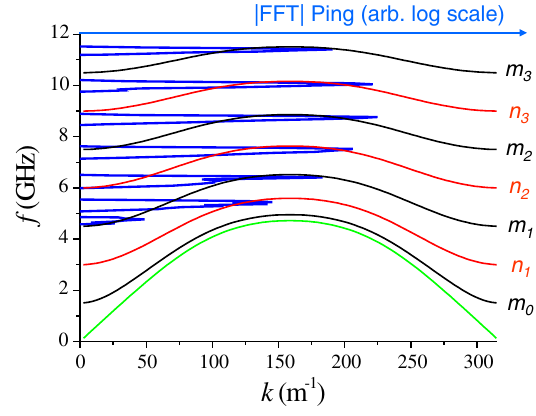
FIG. 2. The 2D dispersion relation for the grating is shown in green. For the grating with sidewalls, the 3D symmetric higher modes are shown in black, and the antisymmetric modes in red. The blue curve shows the FFT of a ping, which correlates very well with the maxima of these seven branches of the dispersion